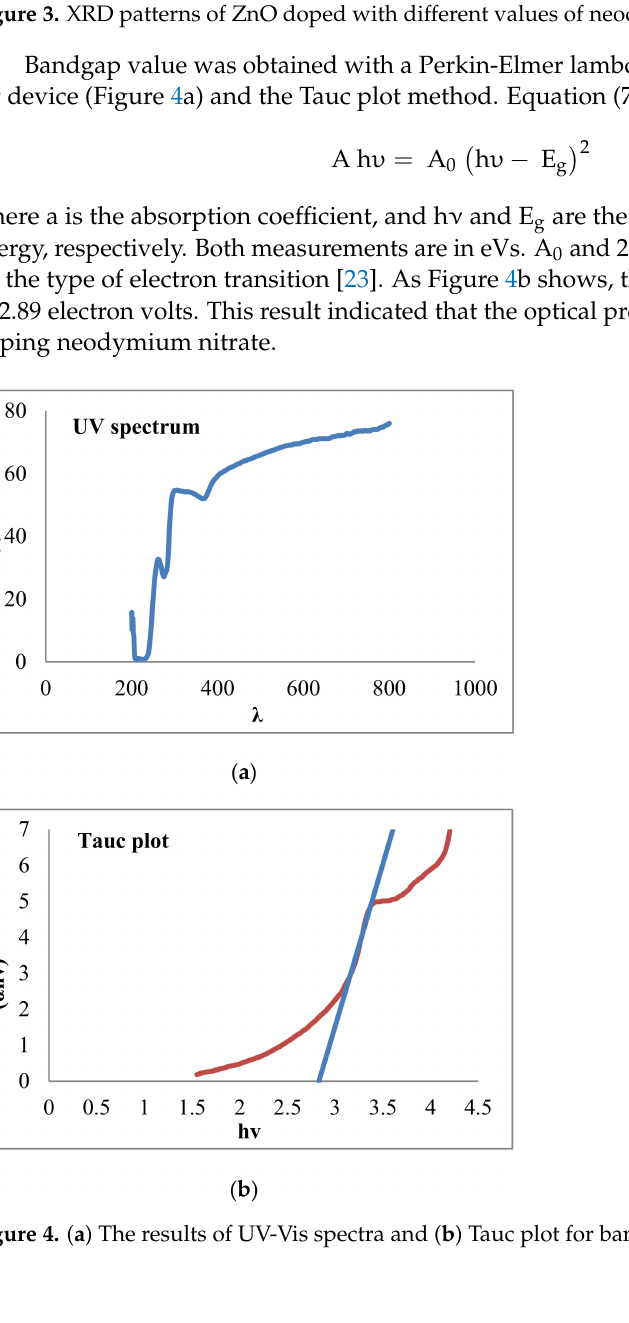
Figure 4. ( a ) The results of UV-Vis spectra and ( b ) Tauc plot for bandgap energy of